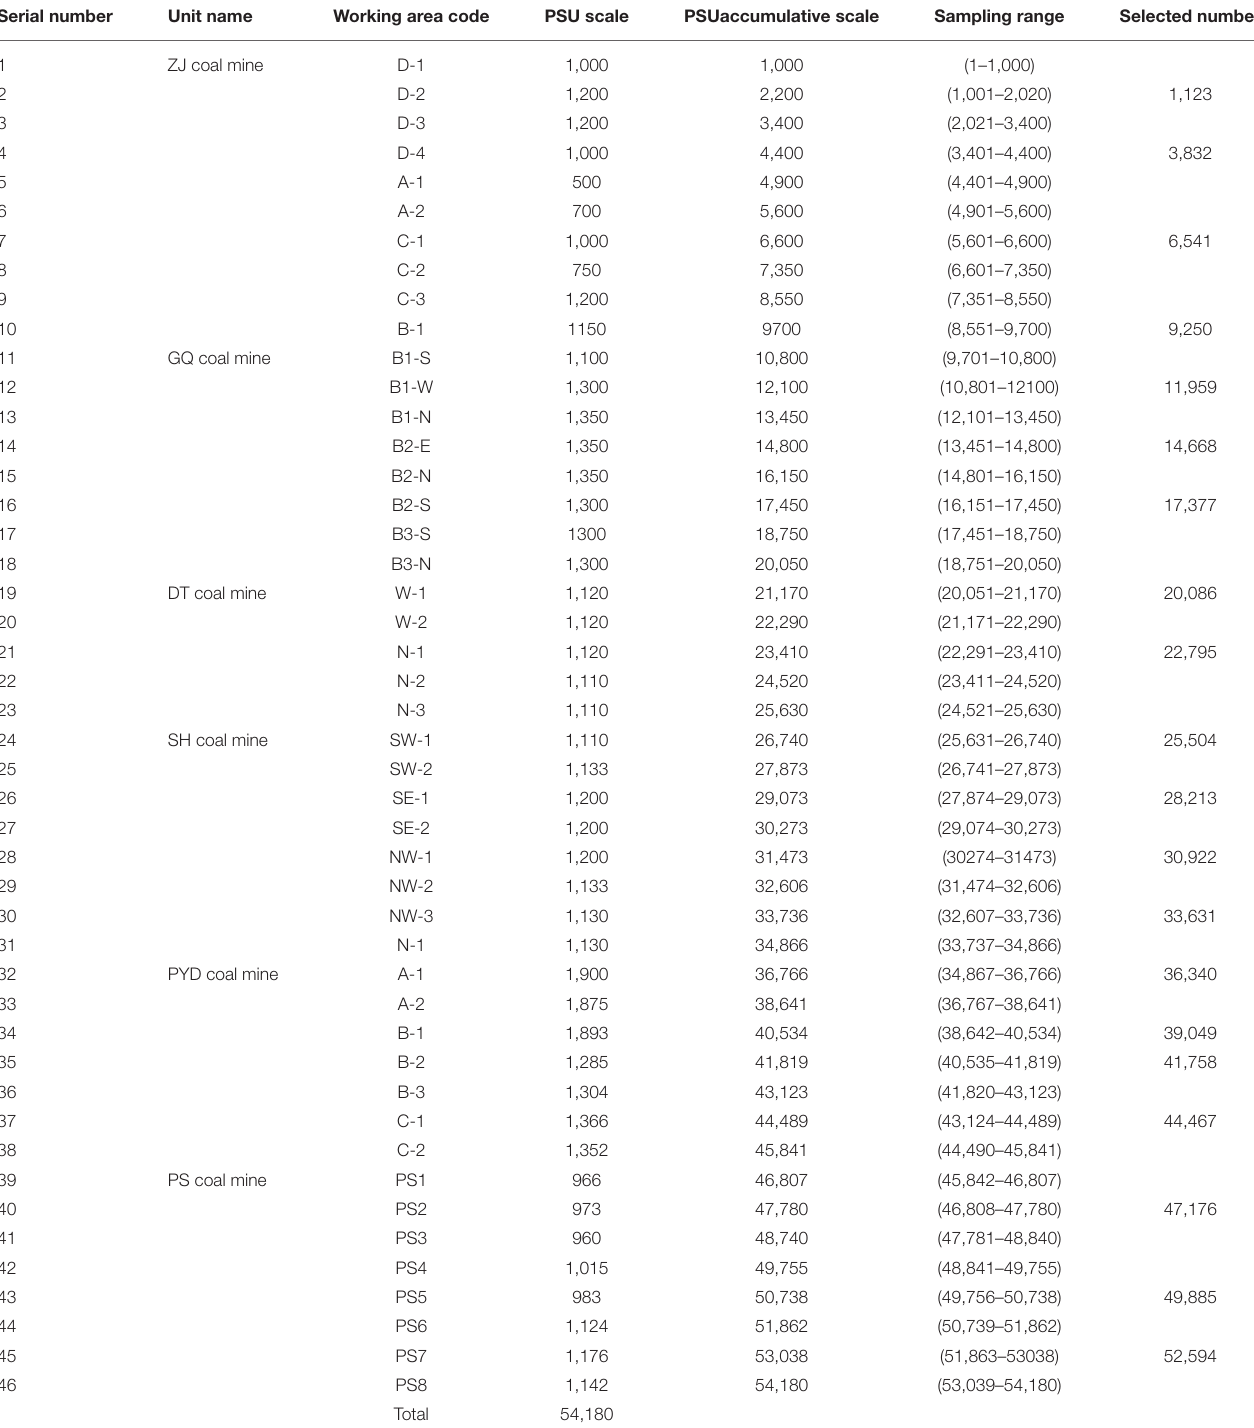
TABLE 2 | Group distribution of coal mine workers in two cities: A and